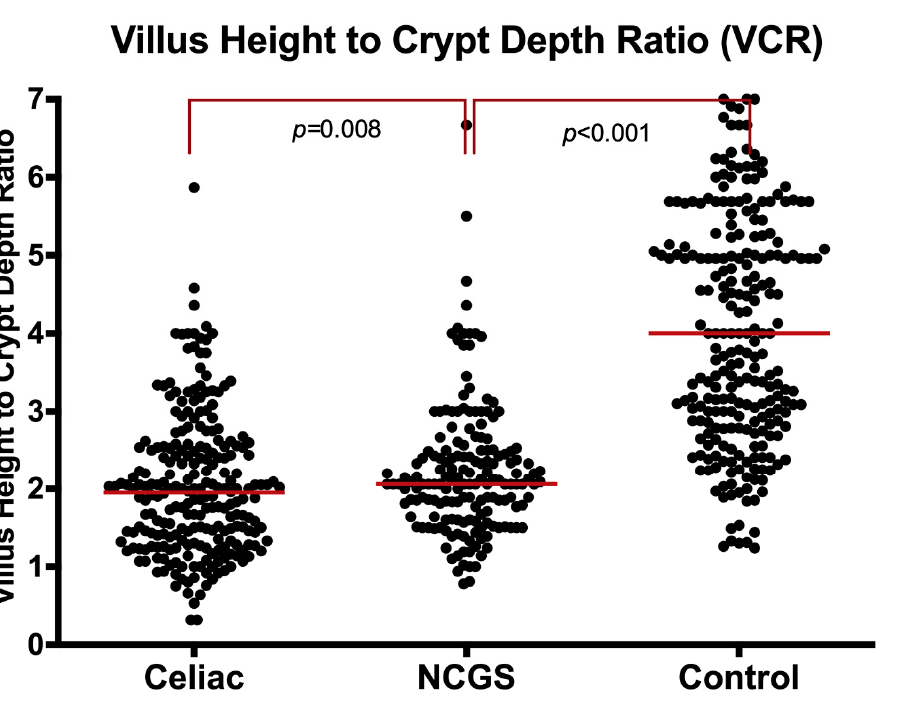
Figure 3. Villus height to crypt depth ratio (VCR) in NCGS compared to CeD and controls, entire cohort.